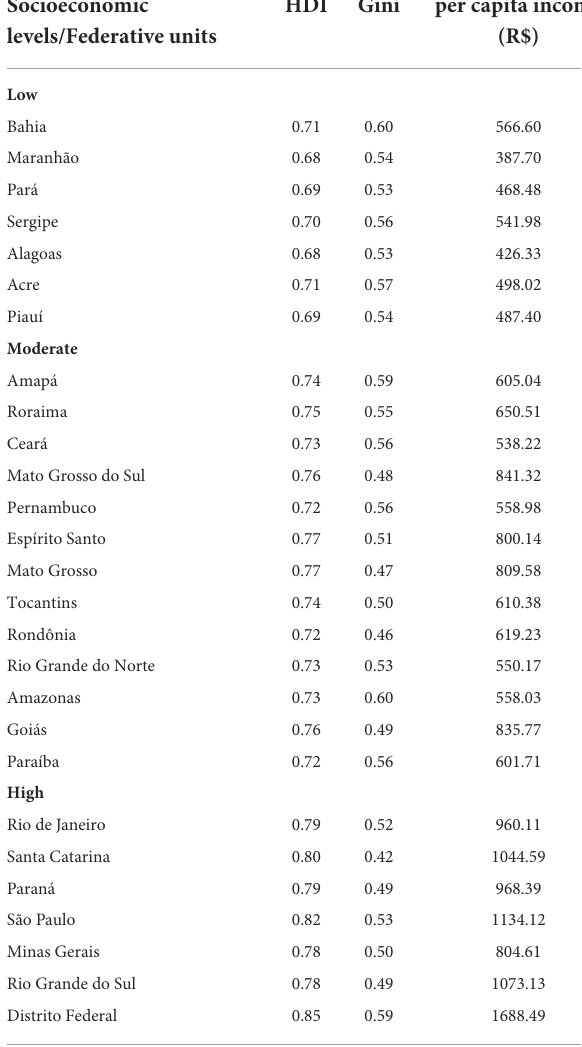
TABLE 2 Description of the socioeconomic variables of the study on mortality from female breast cancer in the federal units of Brazil, 2017. Socioeconomic levels/Federative